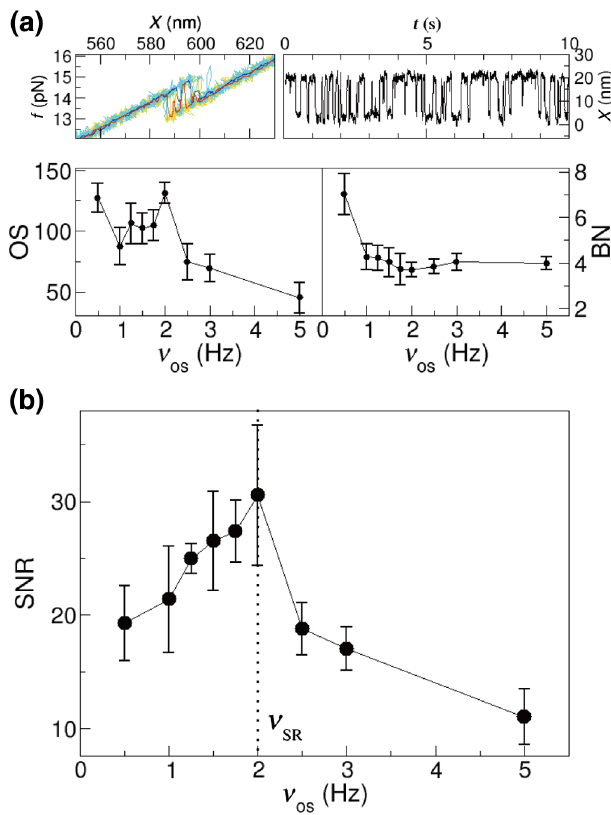
FIG. 3. SR experiments for hairpin H1 with long DNA handles. (a) Upper left: pulling cycle (unfolding, blue; refolding, red). The dark blue and red curves are the time-averaged data of the paler blue and yellow lines, respectively. Upper right: hopping trace. Lower left: OS. Lower left: BN. (b) The resulting SNR in the case of high trap stiffness (cid:4) trap ¼ 70 pN =(cid:5) m and the ampli- tude A ¼ 0 : 7 pN . Results have been averaged over 5 molecules. Units: OS ( nm 2 ), BN ( nm 2 = Hz ), SNR (Hz). The error bars represent the standard errors over different